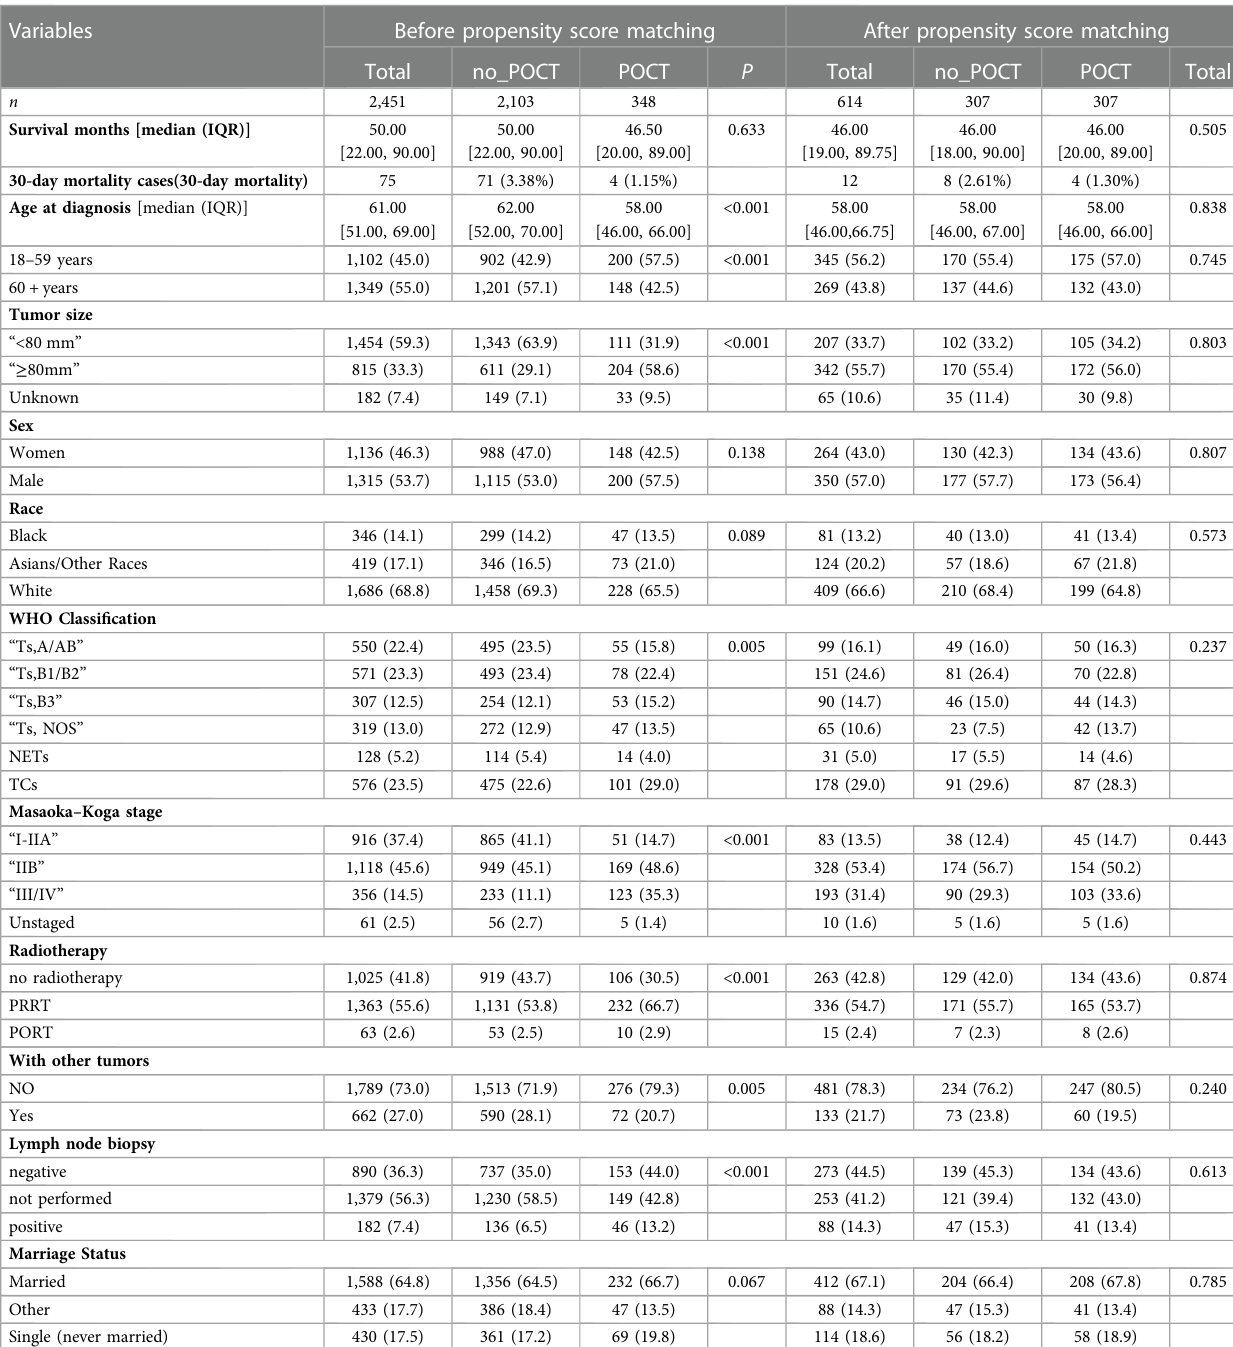
TABLE 2 Clinicopathological characteristics of patients with thymic epithelial tumor surgery before and after propensity score matching. Variables Before propensity score matching After propensity score matching